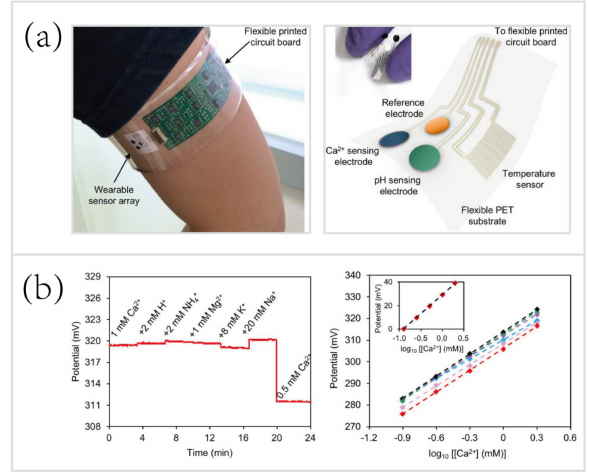
Figure 3. A fully integrated electrochemical biosensor for non-invasive in situ analysis of biofluids. ( a ) An image and a schematic illustration of a fully integrated potentiometric biosensor, consisting of Ca 2 + , pH, and temperature sensors patterned on PET substrate ( b ) Performance test results of Ca 2 + sensors: ion-selectivity and reproducibility (n = 6) [32]. Copyright 2016, American Chemical